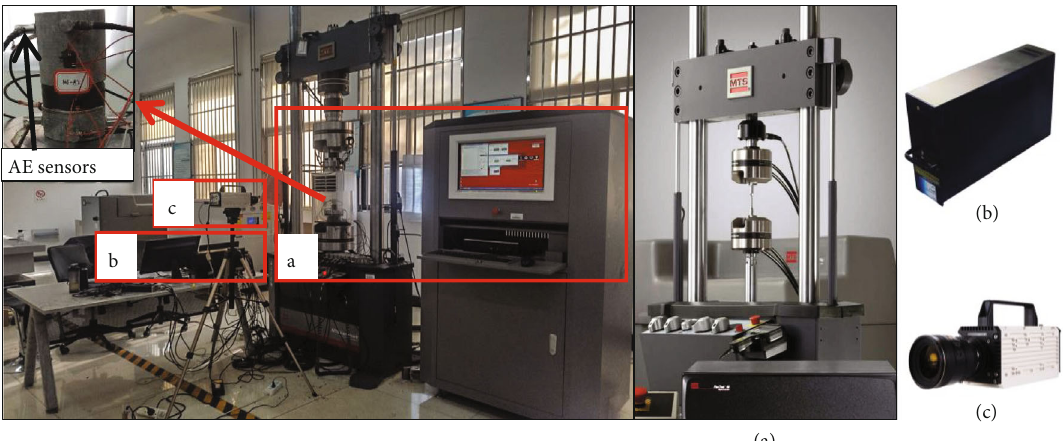
Figure 2: Test device and measuring system. (a) MTS Landmark 370.50; (b) PCI-II AE system; (c) NAG GX-3 high-speed camera.